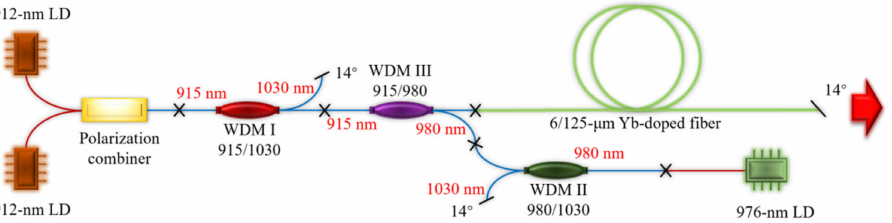
Figure 2. The experimental